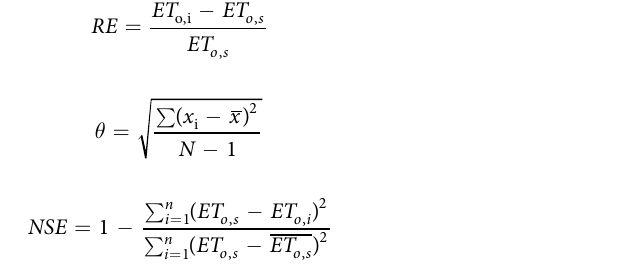
∑ − = = − ∑ − where N = 1, 2, … , 636th month. If RE is close to 0, ET o,i is close to ET o,s . The NSE values ranged from −∞ to 1. When NSE is close to 1, the quality of the method for estimating ET o,i is good with high reliability. When NSE is close to 0, ET o,i has an close mean value with ET o,s with an overall reliable estimation, but the errors of the estima- tion processes are large; when NSE is much less than 0, the estimation is not reliable. Trend test. The modified nonparametric Mann-Kendall (MMK) test 72 , which takes into account the effects of auto-correlation in annual time series ET o,L ( L = 1, 2, … , n 1 , where n 1 = 53 is total year number) based on the standardized Mann-Kendall (MK) method 73, 74 , is used to test the trend of ET o,L if it is auto-correlated 8 . The MK test statistic ( Z ) follows the standard normal distribution with a mean of 0 and variance of 1 under the null hypothesis of no trend in ET o,L . The null hypothesis is rejected if | Z | ≥ Z 1- β /2 at a confidence level of β , where Z 1- β /2 is the (1- β /2)–quantile. If Z is positive (or negative), ET o,L has an upward (or downward) trend. As β = 0.05, if to Z to | Z | > 1.96, the trend is significant. The MMK statistic Z * is computed by introducing a correction factor n s 1 estimate 72 :